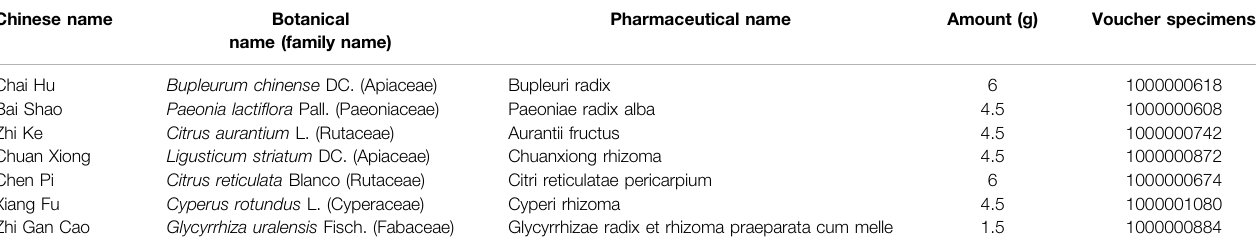
TABLE 1 | The herbal composition of Chaihu-Shugan-San (CSS).